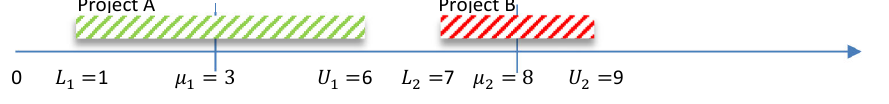
is more preferred 𝒊